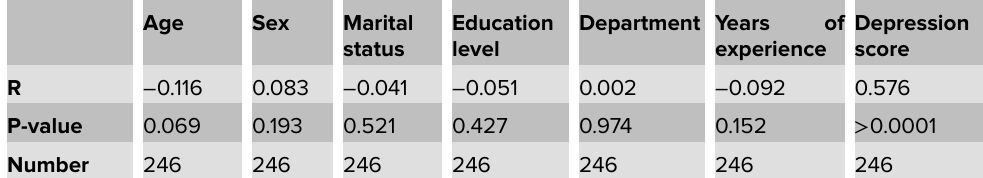
Table 4: Correlation between anxiety score and baseline characteristics.